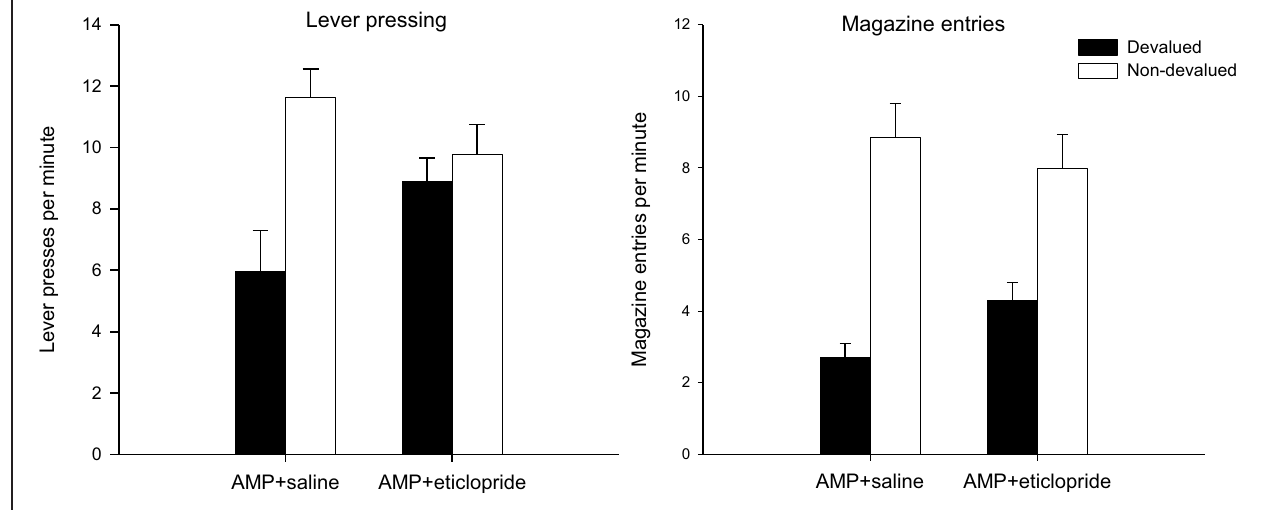
minute and mean magazine entries per minutes as a proportion of baseline ( ± SEM) in the rewarded reacquisition test after devaluation by LiCl (devalued—black bars) or no devaluation (non-devalued—white bars).